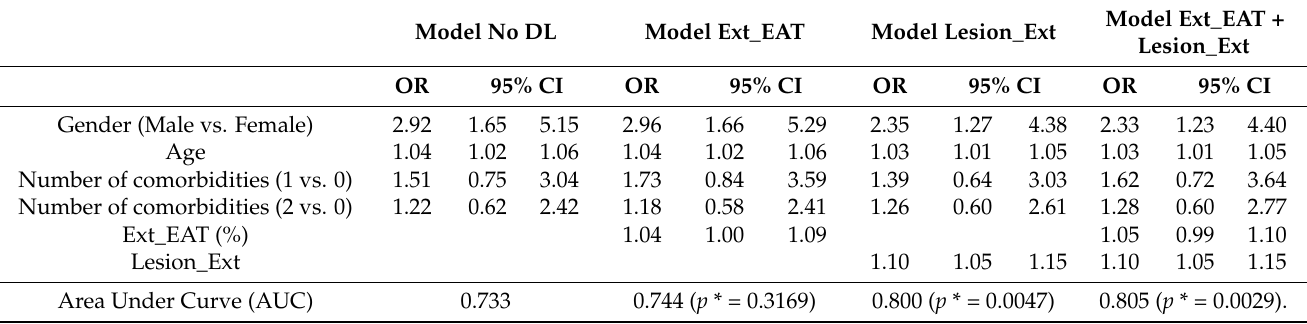
Table 4. Associations with combined clinical outcome (death, ICU transfer, need for oxygen ther- apy, >10 days hospitalization)—Multivariable logistic regressions (n = 238). DL: Deep-learning model; Ext_EAT: epicardial adipose tissue extent (%); Lesion_Ext: COVID-19 lung lesion extent